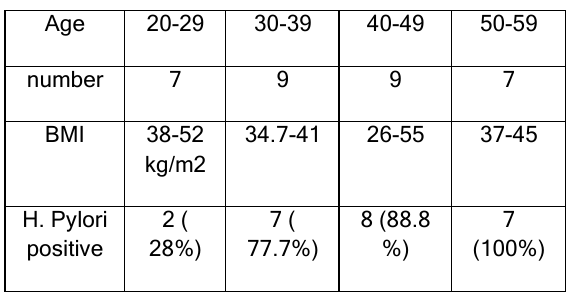
Table 1 Seropositivity of h. pylori in respect to age